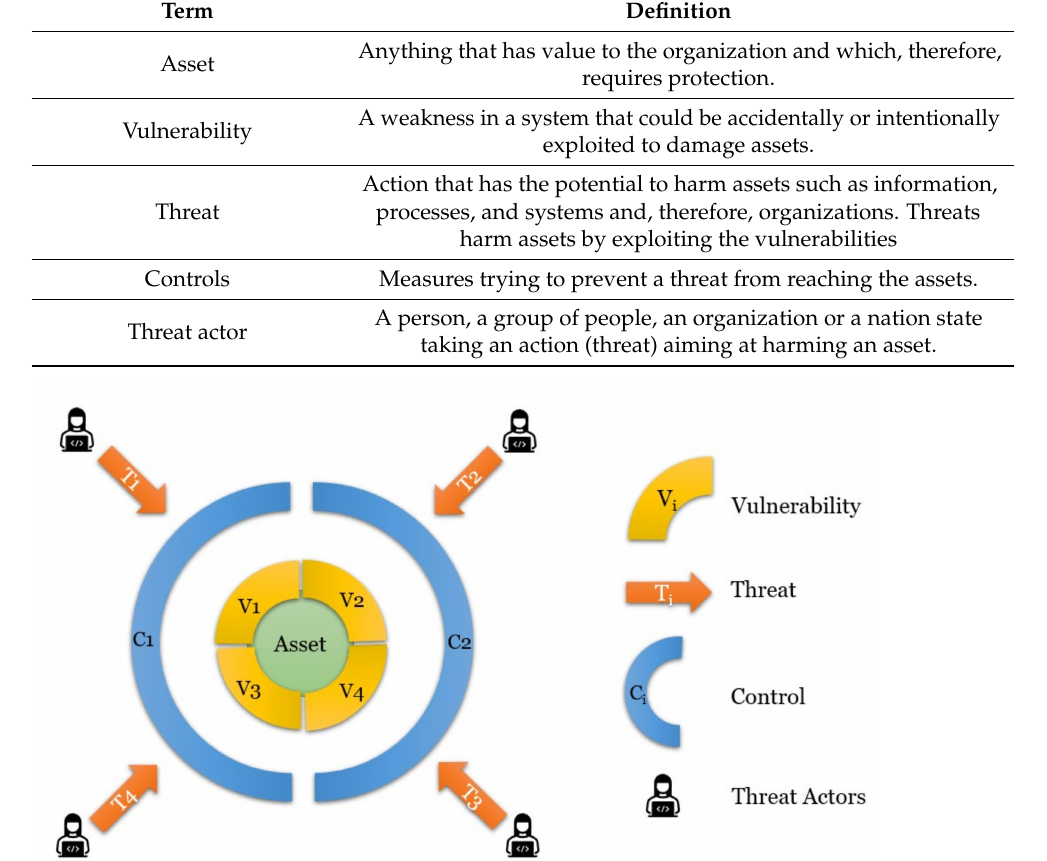
Figure 3. Interactions between assets, vulnerabilities, threats, threat actors, and controls